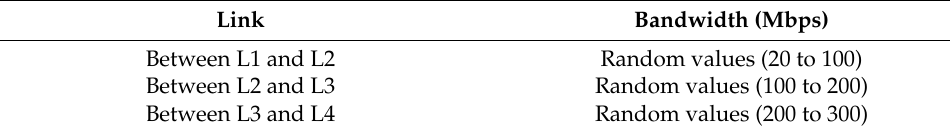
Figure 5. Experimental Scenario 2 topology. Table 2. Bandwidth settings for Experiment Scenario 2 topology.